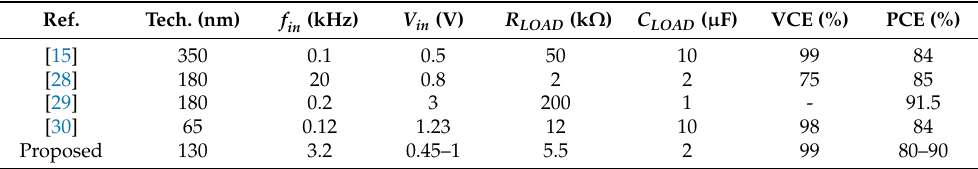
Table 2. Research